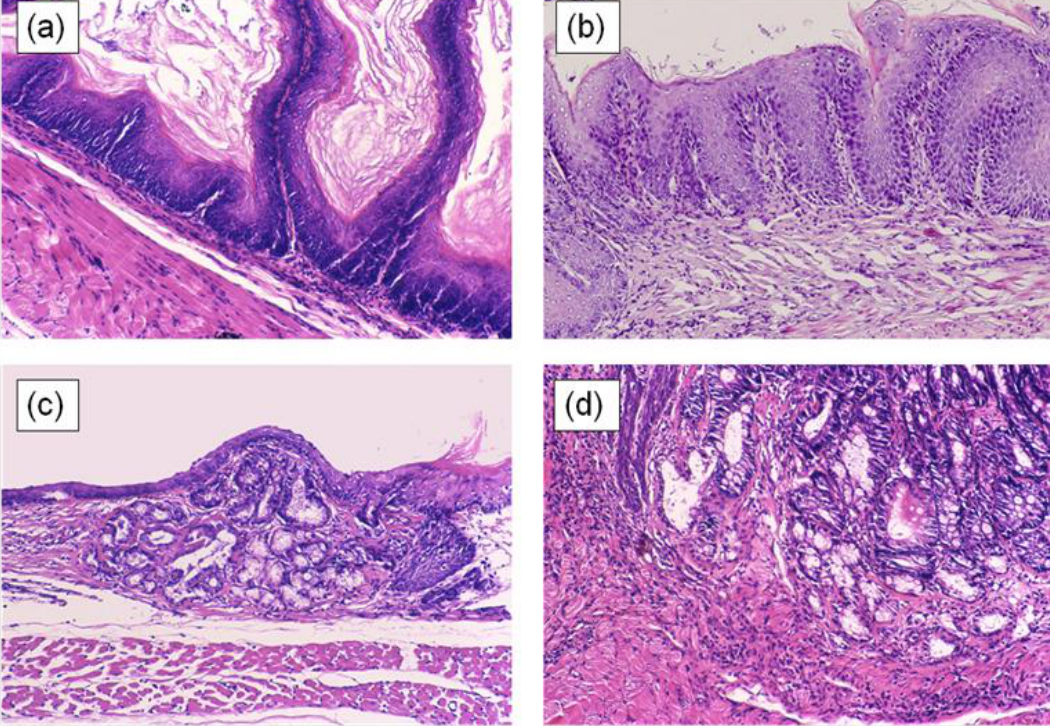
Figure 5. Microscopic findings in the rat duodenoesophageal reflux model. ( a ) Regenerative thickening, esophageal epithelium with more than double the normal thickness, together with acanthosis, abnormal extension of papillae toward the mucosal surface, and parakeratosis; ( b ) Basal cell hyperplasia, thickening of the basal layer of the squamous epithelium resulting in its occupation of more than 15% of the epithelial layer. The stratified structure of the squamous epithelium is preserved; ( c ) Barrett's esophagus, replacement of squamous epithelium with columnar-lined epithelium consisting of gastric and/or intestinal cells; ( d ) Adenocarcinoma, epithelial growth with cellular and structural atypism, invading into the submucosal